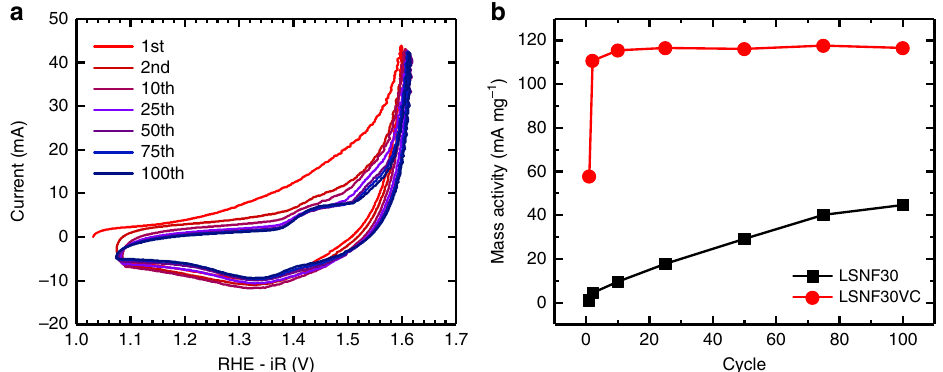
Fig. 3 Cyclic voltammetry stability tests of LSNF30 dropcast on Ni foam electrodes at 1 mg cm − 2 . a One hundred cycles of LSNF30 supported at 30 wt% on VC performed in O 2 -saturated 0.1 M KOH at 10 mV s − 1 . b Mass activities measured at 1.63 V for both LSNF30VC and unsupported LSNF30 at various points during the 100 cycle stability tests. Mass activities were calculated by subtracting the current at 1.63 V for an Ni foam electrode with or without carbon but without catalyst from the current measured from the catalyst on Ni foam with or without the VC support and then dividing by the mass